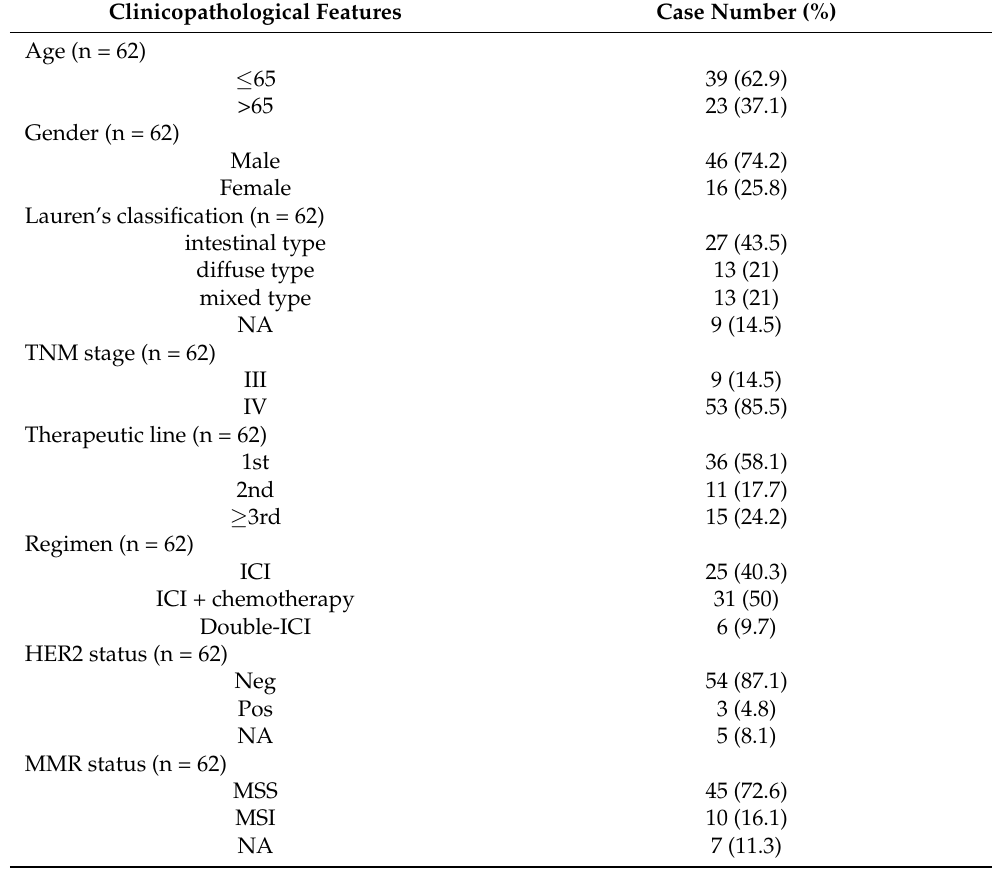
Figure 1. The overall workflow of our study. Table 1. Clinicopathological features of the discovery cohort (n = 62).